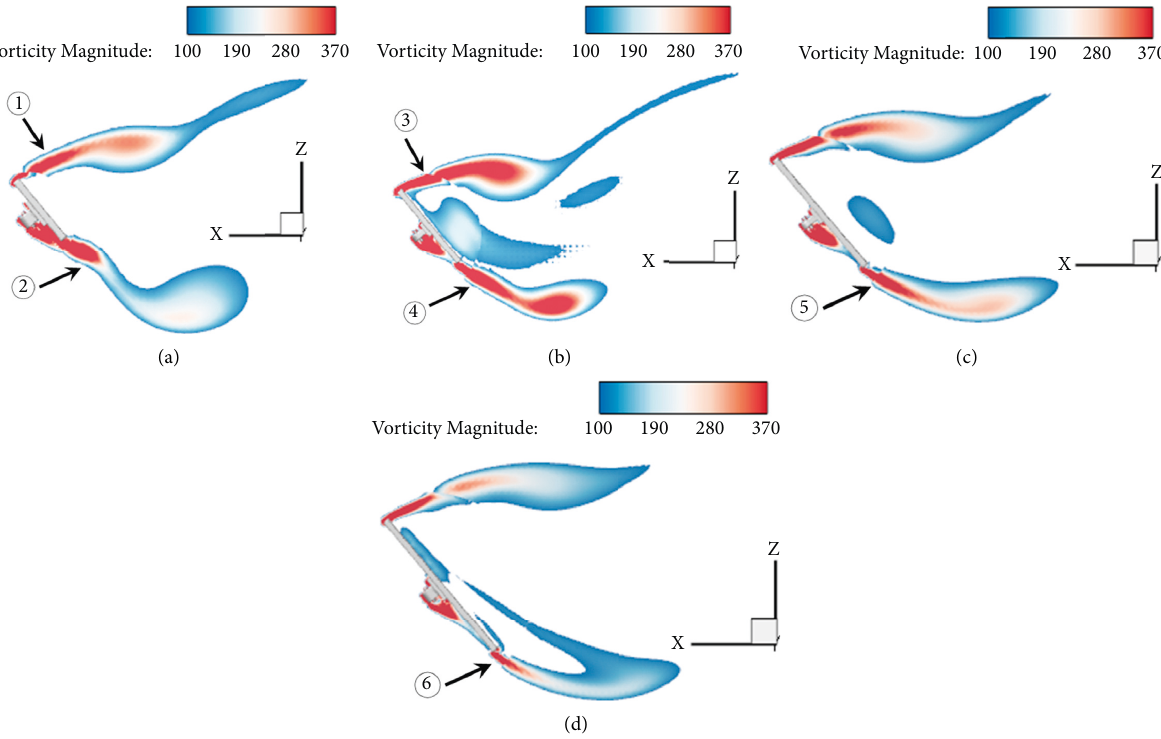
Figure 8: Variation of cloud pattern of antenna vorticity field relative to aspect ratio: (a) AR � 0.5, (b) AR � 1.5, (c) AR � 2.0, and (d) AR � 2.5 ( β � 220 ° , K � 0.2, ZOX plane, and Y � 0).